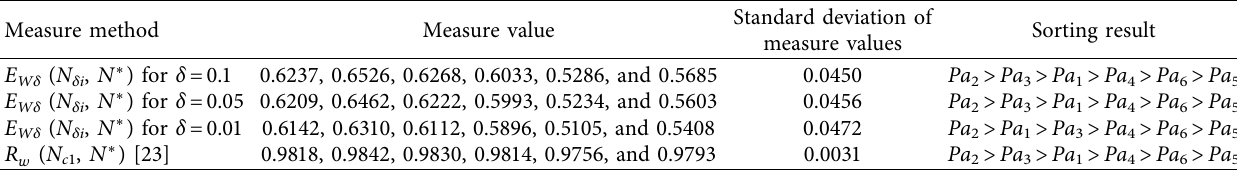
Standard deviation